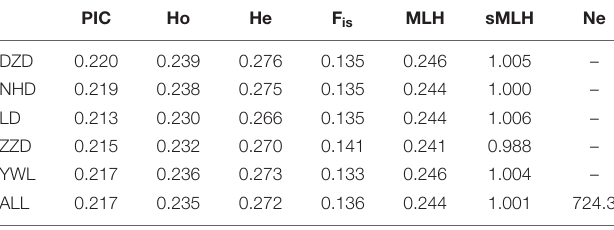
TABLE 1 | Genetic diversity summary of Mesocentrotus nudus from five localities in China.